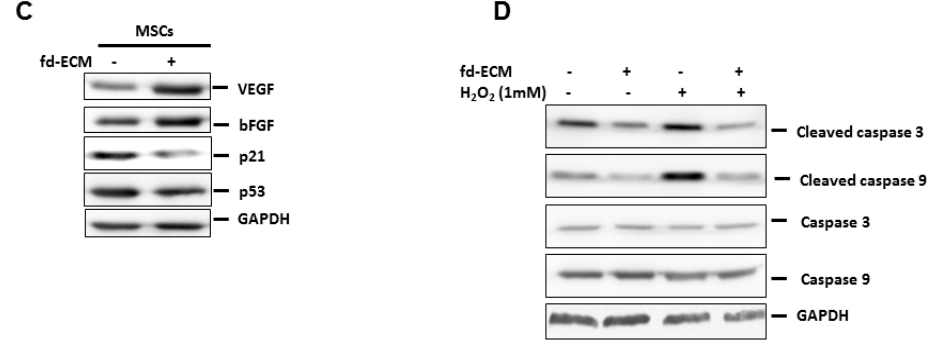
Figure 9. Anti-senescence effect of fd-ECM on ad-MSCs. ( A ) Ad-MSCs were cultured on plastic dishes ( − ) and on fd-ECM (+) for 48 h, harvested, and total RNA extracted. RT-qPCR was performed to evaluate human Telomerase Reverse Transcriptase ( hTERT ), VEGF , and bFGF mRNA levels; ( B ) Ad-MSCs were cultured on plastic and on an fd-ECM for 48 h, harvested, and total RNA extracted. RT-qPCR was performed to evaluate P16 , P21 , and P53 mRNA levels; ( C ) Ad-MSCs were cultured on plastic ( − ) and on fd-ECM (+), harvested, and immunoblot analysis was performed to evaluate VEGF, bFGF, p21, and p53 protein levels; and ( D ) ad-MSCs were cultured on plastic ( − ) and on an fd-ECM (+) and immunoblot analysis was performed to evaluate cleaved caspases 3 and 9 protein levels. * p < 0.05.